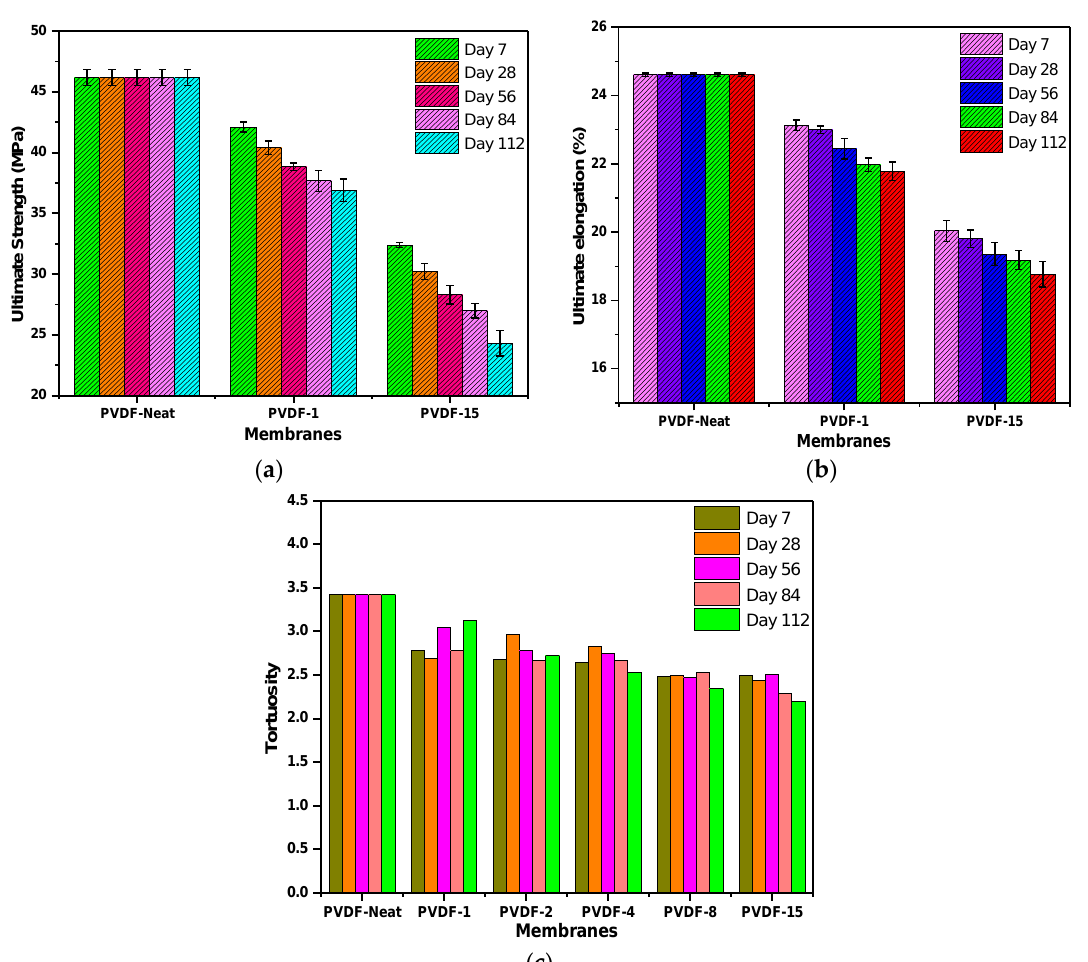
Figure 6. Mechanical properties of representative membrane samples: ( a ) ultimate strength of the membranes; ( b ) ultimate elongation of the membranes; ( c ) tortuosity of the membranes.